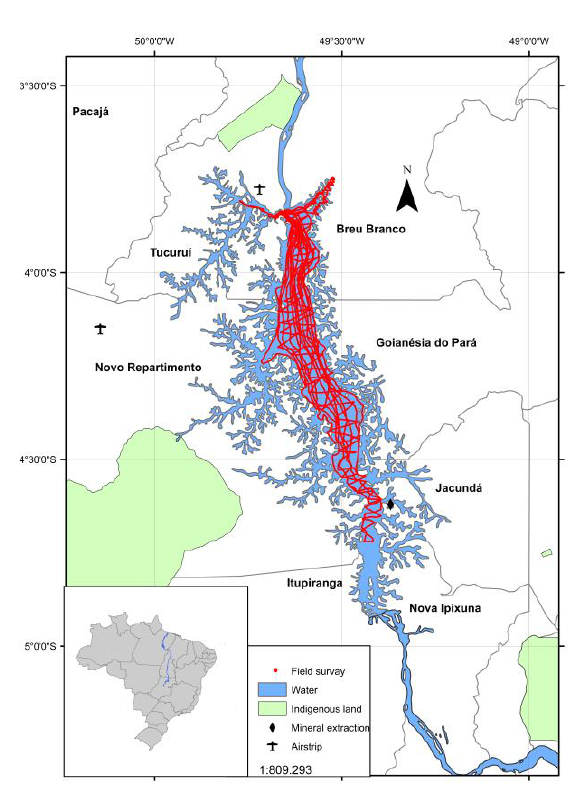
Figure 1. Location of study area: